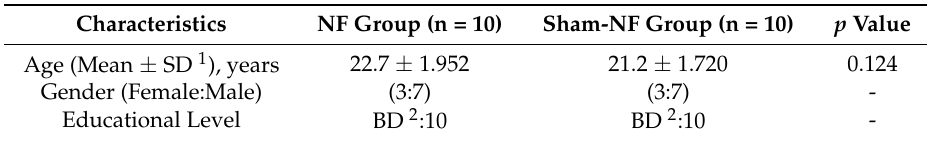
Table 1. Demographic characteristics of the